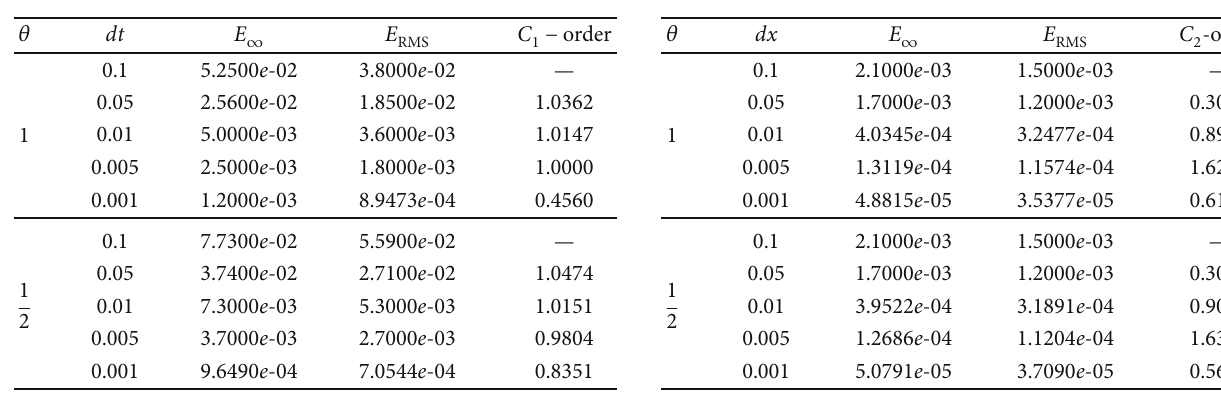
Figure 9: Approximate solution at di ff erent time levels by using (a) IS and (b) CNS for Problem Table 8: Error norms at t = 1 for di ff erent time steps with c = 5 : 9, Table 9: Error norms and computational order for di ff erent dx with N = 50 for the Problem 4. c = 100, α = 1 : 5, and t = 0 : 1 for the Problem 4.